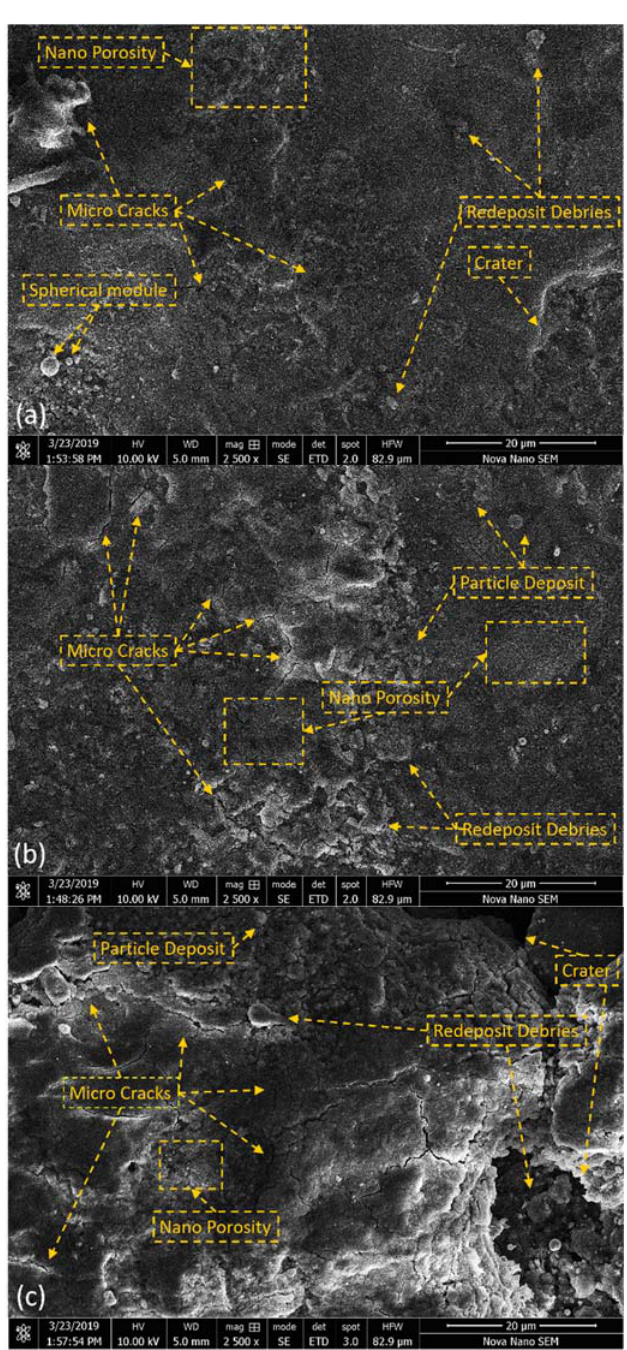
Figure 5. Surface Topography: SEM micrographs of modified surfaces using Si concentration ( a ) 5 g/L and 5A Ip ( b ) 10 g/L and 7A Ip ( c ) 20 g/L and 9A Ip on 2500× magnification.